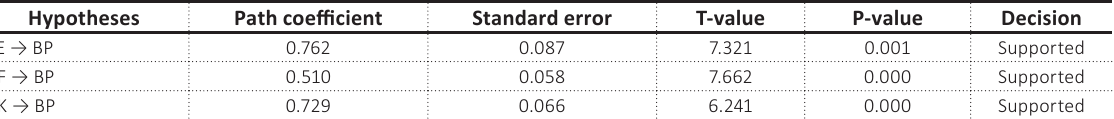
Source: SmartPLS 3.2.7 output on research data,